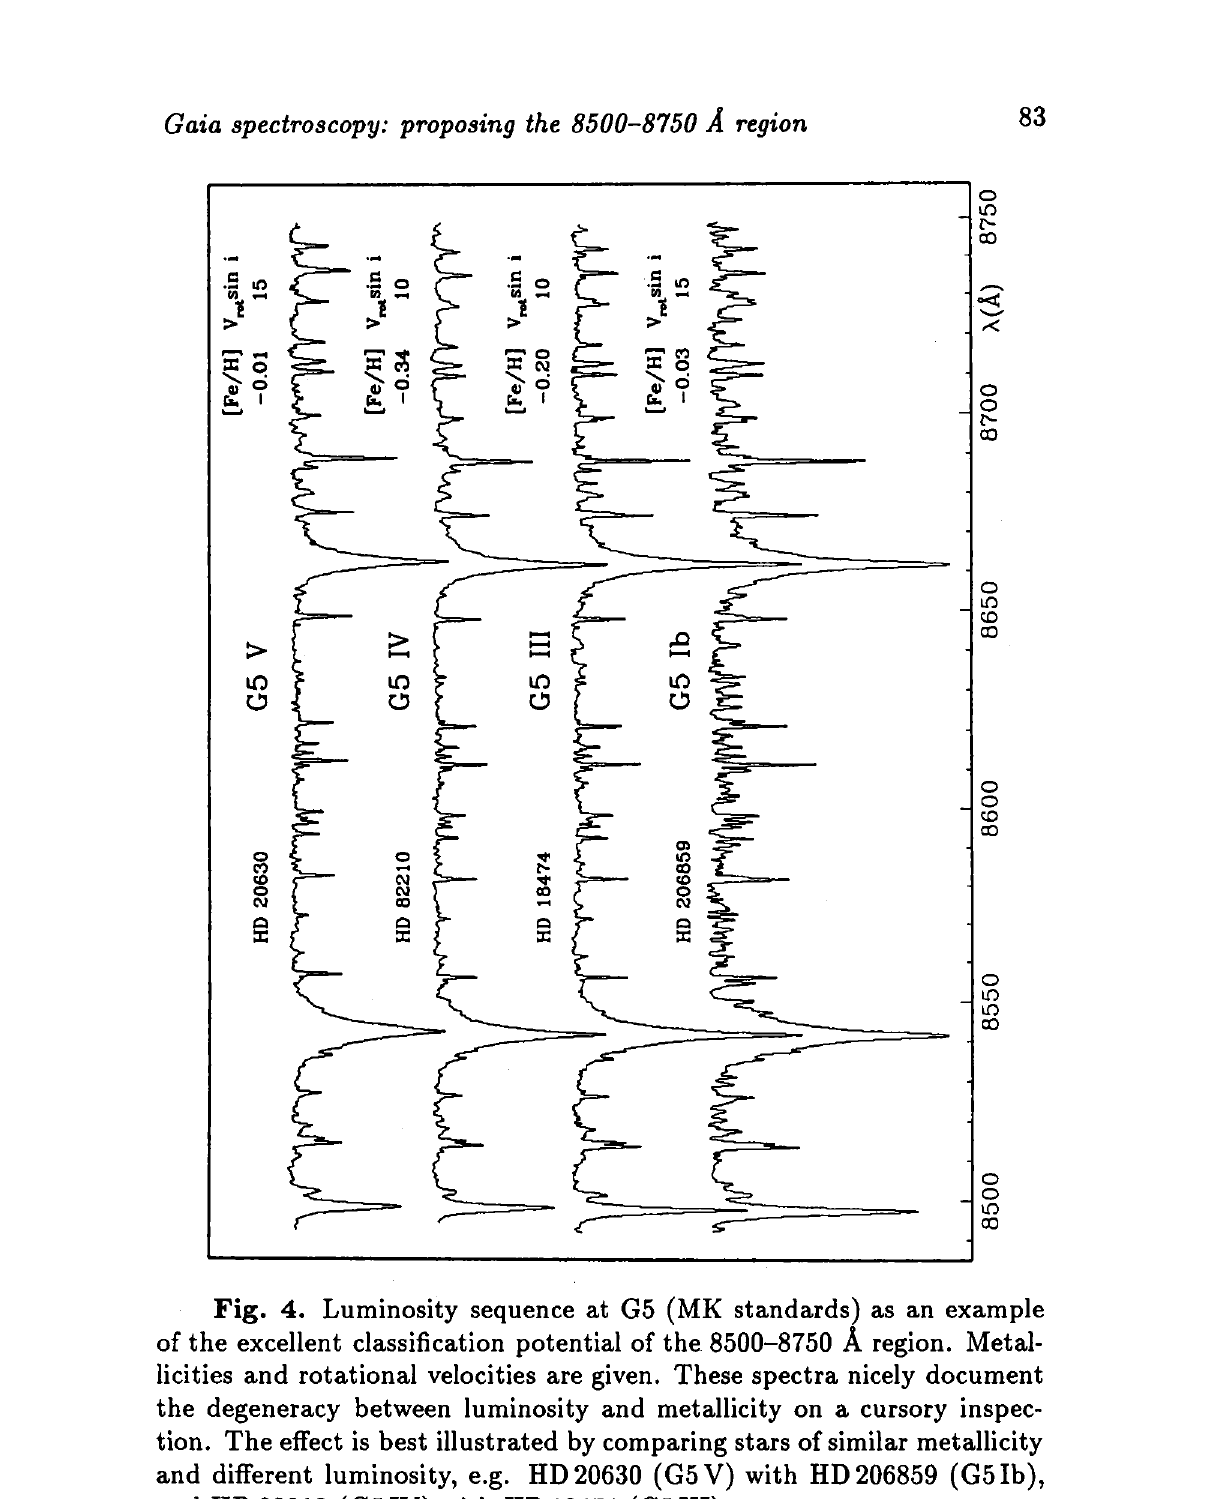
Fig. 4. Luminosity sequence at G5 (MK standards) as an example of the excellent classification potential of the 8500-8750 Â region. Metal- licities and rotational velocities are given. These spectra nicely document the degeneracy between luminosity and metallicity on a cursory inspec- tion. The effect is best illustrated by comparing stars of similar metallicity and different luminosity, e.g. HD 20630 (G5V) with HD 206859 (G5Ib), and HD 82210 (G5IV) with HD 18474